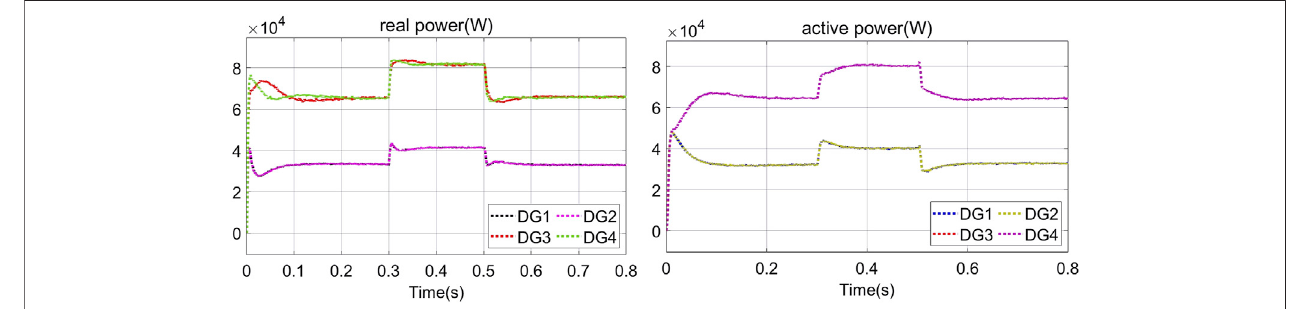
FIGURE 10 | Power sharing under load